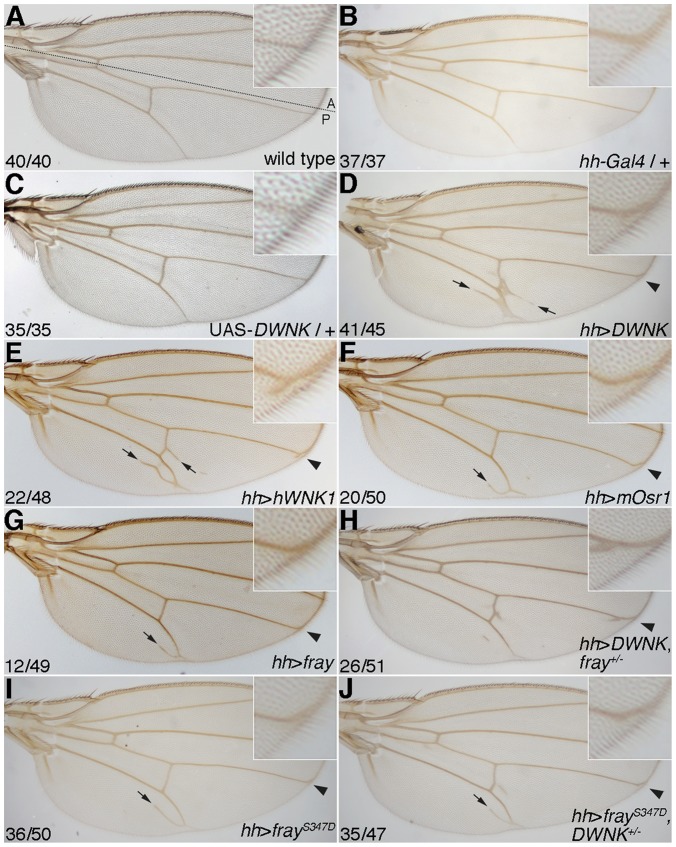
Conservation of the WNK-OSR1 pathway.(A) Wild-type wing. Dotted line indicates the anterior (A)-posterior (P) boundary. (B–C) Wings from heterozygous hedgehog (hh)-Gal4 (B) or UAS-DWNK (C). Both wings did not show any phenotype. (D–G) Wings from EY10165 (UAS-DWNK) (D), UAS-hWNK1 (E), UAS-mOsr1 (F) and UAS- fray (G) flies driven by hh-Gal4. Additional vein around vein 5 (arrow) and delta phenotype at vein 4 (arrowhead) were observed. (H) Wing from flies overexpressing DWNK driven by hh-Gal4 with fray07551 heterozygous mutant. (I–J) Wings from frayS347D overexpression flies driven by hh-Gal4 without (I) or with (J) DWNKEY18 heterozygous mutant. The numbers of wings showing the phenotypes and of total observed wings were indicated. Anterior is up. Distal is right. Insets of upper right corner show the magnification around vein 4. The detail genotypes in this figure were followings: (A) Canton-S (wild type): (B) y w hsflp/y w; hh-Gal4/+: (C) y w; EY10165/+: (D) y w; hh-Gal4/EY10165: (E) y w hsflp/y w; hh-Gal4/UAS-hWNK1: (F) y w hsflp/y w; UAS-mOSR1/+; hh-Gal4/+: (G) y w hsflp/y w; UAS-fray/+; hh-Gal4/+: (H) y w hsflp/y w; hh-Gal4 EY10165/fray07551: (I) y w hsflp/y w; hh-Gal4/UAS-fray
S347D: (J) y w hsflp/y w; hh-Gal4 UAS-fray
S347D/DWNKEY18. See also Fig. S2.